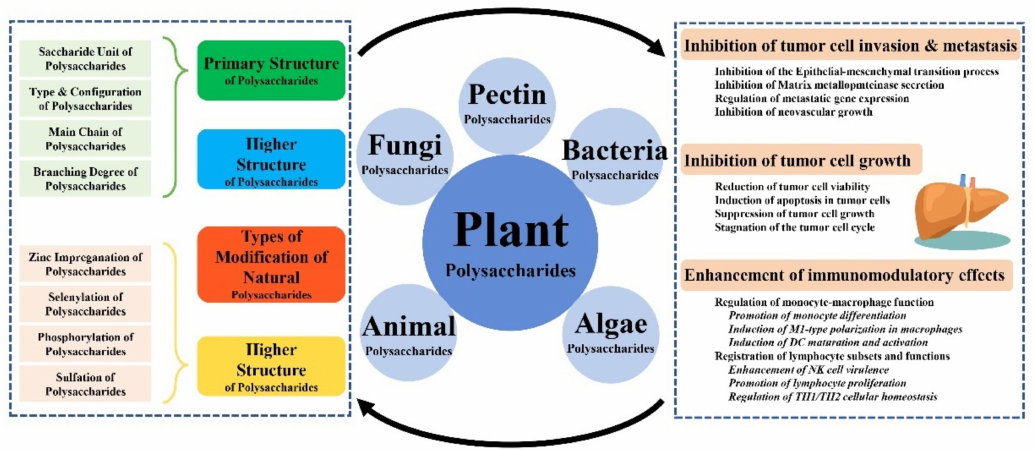
Figure 14. Antitumor mechanism of plant polysaccharides and their conformational